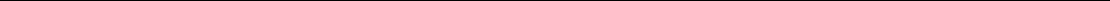
Fig. 3 CAFs can stimulate cancer cell invasion in an MMP-independent manner. a HCT116 cancer cells co-cultured with CAFs on mouse mesentery for 10 days. Top view: CAFs (arrow head) breached the BM and migrated into the cancer cell (arrow) compartment. Bottom view: fi broblast compartment. Cells visualized by staining of the F-actin cytoskeleton (phalloidin, red) and DNA (DAPI, green). The basement membrane detected by re fl ection (blue). Scale bars, 20 µ m. b Manually selected list of proteins with protease activity present in higher (pink) or lower (green) amounts in CAFs from patients 1 or 2 compared to their paired counterparts NAFs. For each protein, fold change and p -value are presented. c Quanti fi cation of cancer cell invasion through mesenteric BM in the presence of different drugs. For MMP inhibitor GM6001 and CAFs from patients 1 and 2, data from one experiment ( n = 5 – 8 per condition) are presented. For MMP inhibitor BB94 and CAFs from patients 3 ( n = 13 – 17 per condition) and 4 ( n = 10 – 11 per condition), data are presented from three (patient 3) and two (patient 4) independent experiments. All conditions are reported to their respective controls. Mean ± s.e.m. *** p < 0.0001; ** p < 0.001; * p < 0.05; pANOVA, Holm – Sidak method. d Scanning electron micrograph of cancer cell and CAF-modi fi ed BM in the presence of 10 µ M BB94. Scale bar: 2 µ m. e AFM quasi-height maps show roughness of mesentery cultured with cancer cells and CAFs, and treated with BB94. f Quanti fi cation of HCT116 cancer cell invasion through mesenteric BM in the presence of different drugs. Left: invasion of cancer cells cultured alone. Right: cancer cells cultured with CAFs. Data are presented from two independent experiments for Pepstatin A, Aprotinin, and Talabostat and three independent experiments for BB94. All conditions are reported to their respective controls. Mean ± s.e.m. *** p < 0.0001; ** p < 0.001; * p < 0.05; pANOVA, Holm – Sidak method NATURE COMMUNICATIONS | 8:924 | DOI: 10.1038/s41467-017-00985-8 |